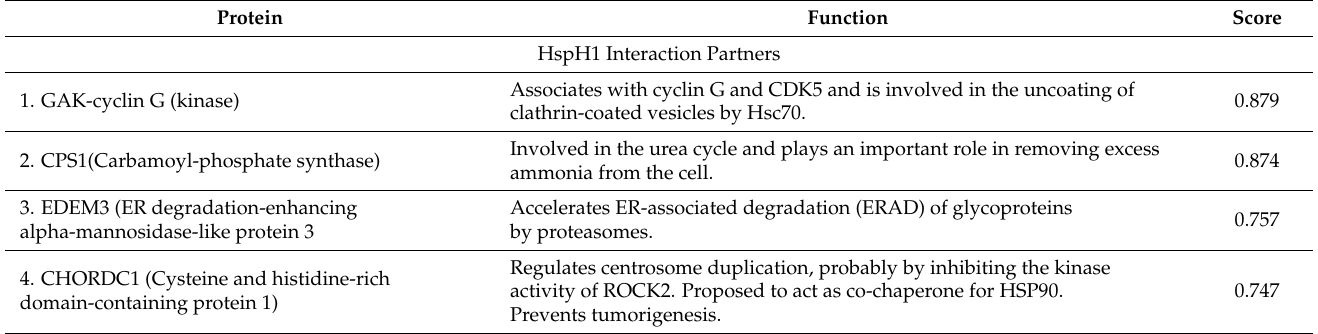
Table 2. Predicted interaction of Hsp110/Grp170 with cancer-associated proteins.